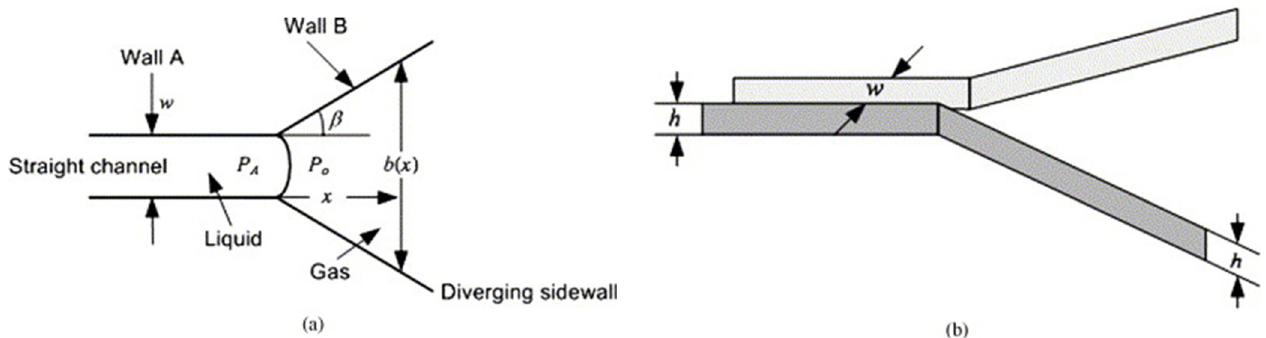
Figure 5. The capillary burst valve in a rectangular channel. ( a ) Top view. ( b ) Bird’s eye view where the h is the height of the channel and w is the width of the channel Permission granted by the pub ‐ lisher